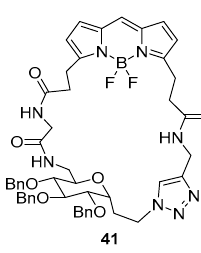
Figure 17. The sugar/ BODIPY conjugates 40 and 41 respond to both cations (Cu 2+ and Fe 3+ ) and